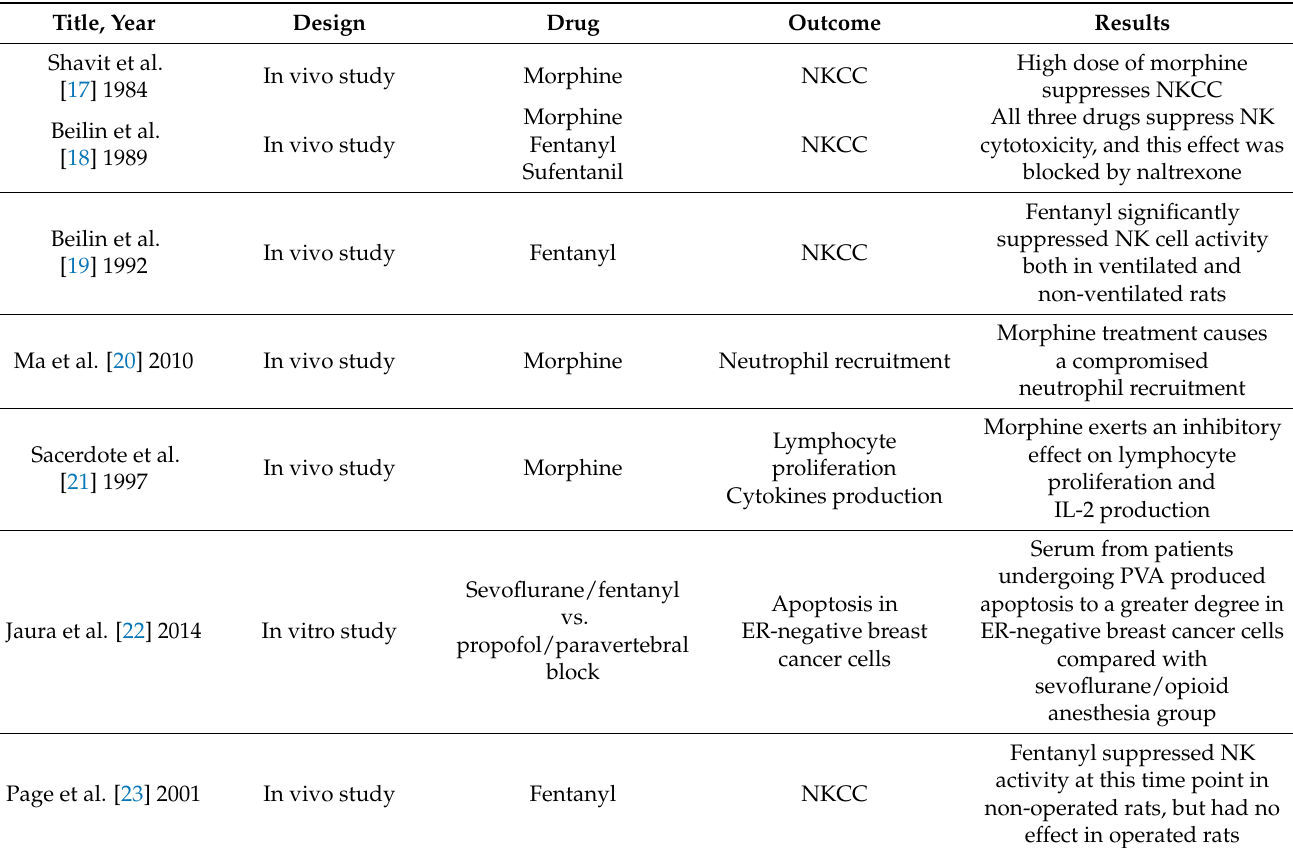
Table 1. Opioids and immune system. Selected preclinical studies. NKCC: natural killer cell cytotoxicity; NK: natural killer; IL-2: interleukin-2; PVA: paravertebral anesthesia; ER: estrogen receptor. Title, Year Design Drug Outcome Results Shavit et